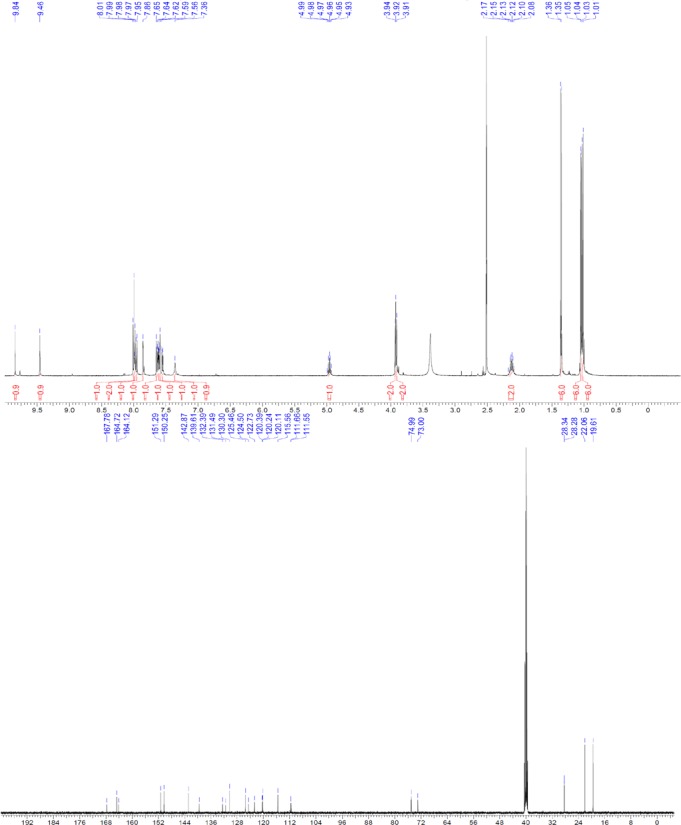
1H and 13C NMR of ERX-8.